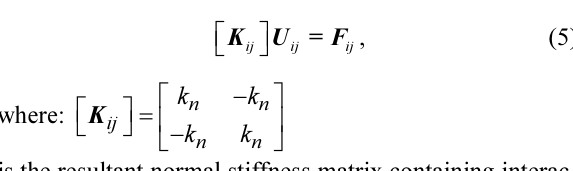
Figure 3. The local Cartesian frame Oxyz positioned at the centre of the sphere i and attached to the connection line ij is introduced for the sake of convenience. Here, axis Oz points to the normal direction, while axes Ox and Oy belong to the tangential plane. The distance between the centres of interacting spheres is denoted by L ij while the separation distance between surfaces is L g (Fig. 3). The centres of spheres are defined by local coordinates z i = 0 and z j = L ij ,